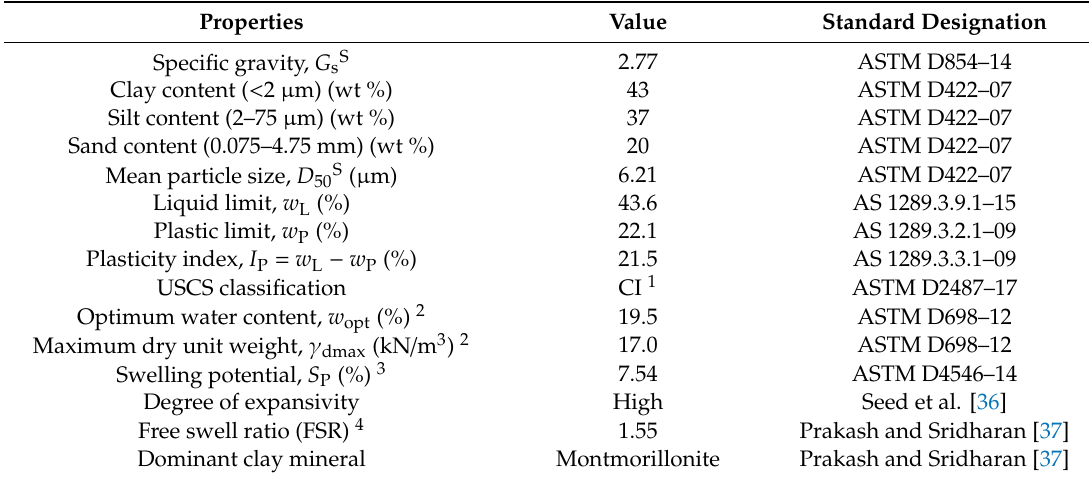
Table 1. Physical and mechanical properties of the test